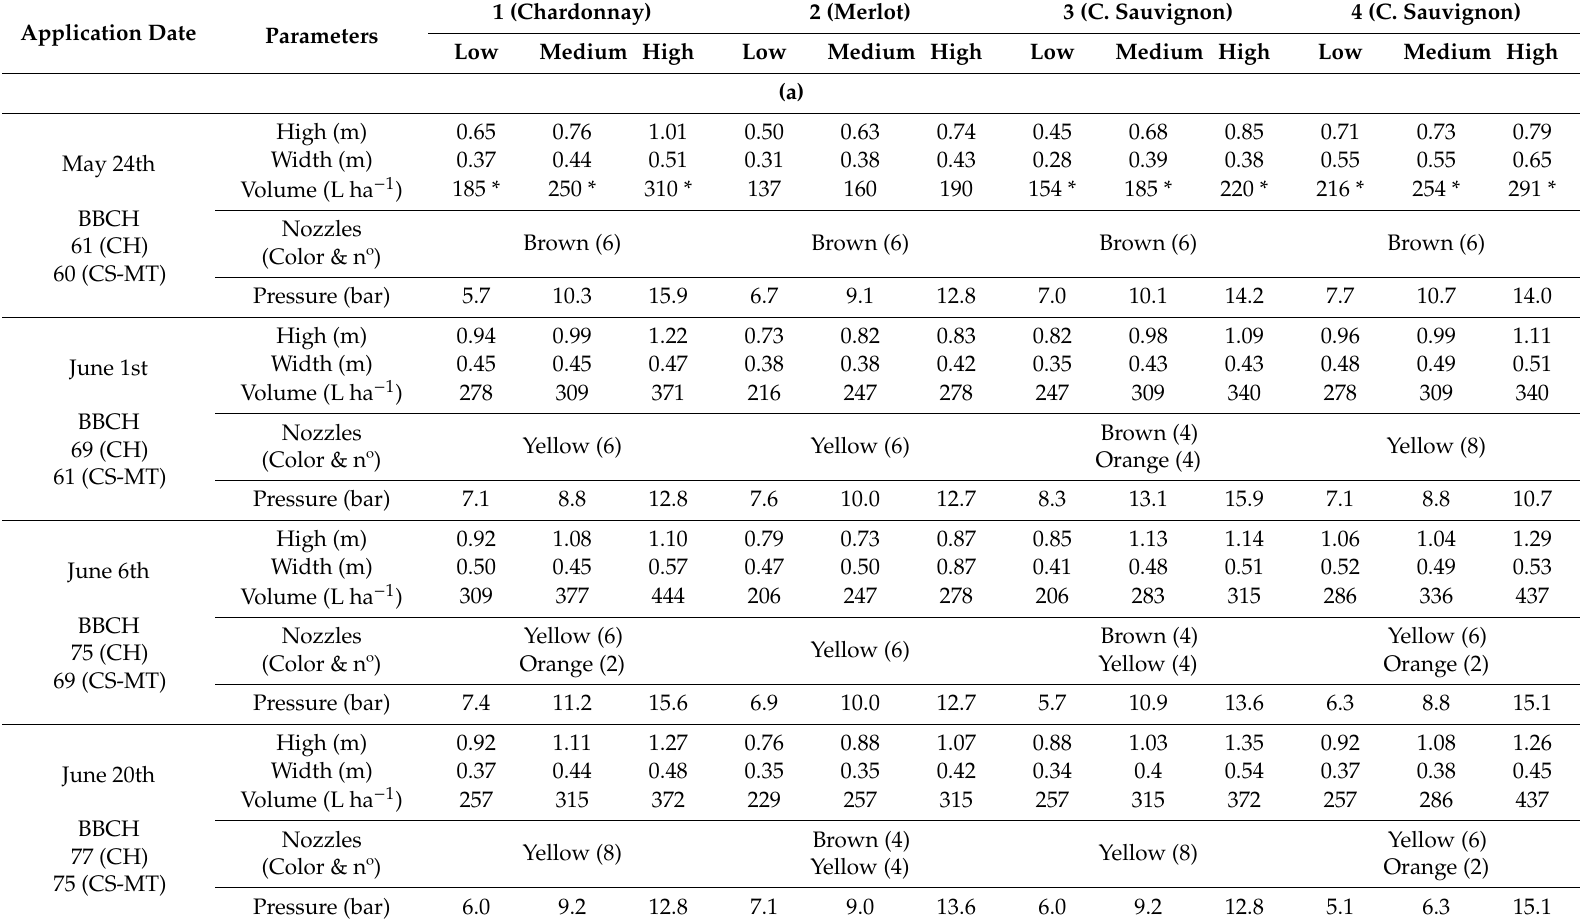
Table 4. Canopy characterization. Volume rate (L ha − 1 ) calculated with Dosaviña ® for each variety and canopy vigor (low, medium and high). Selected working conditions (color, number of nozzles and working pressure) for each pesticide application process (a for 1 to 4, b for 5 to